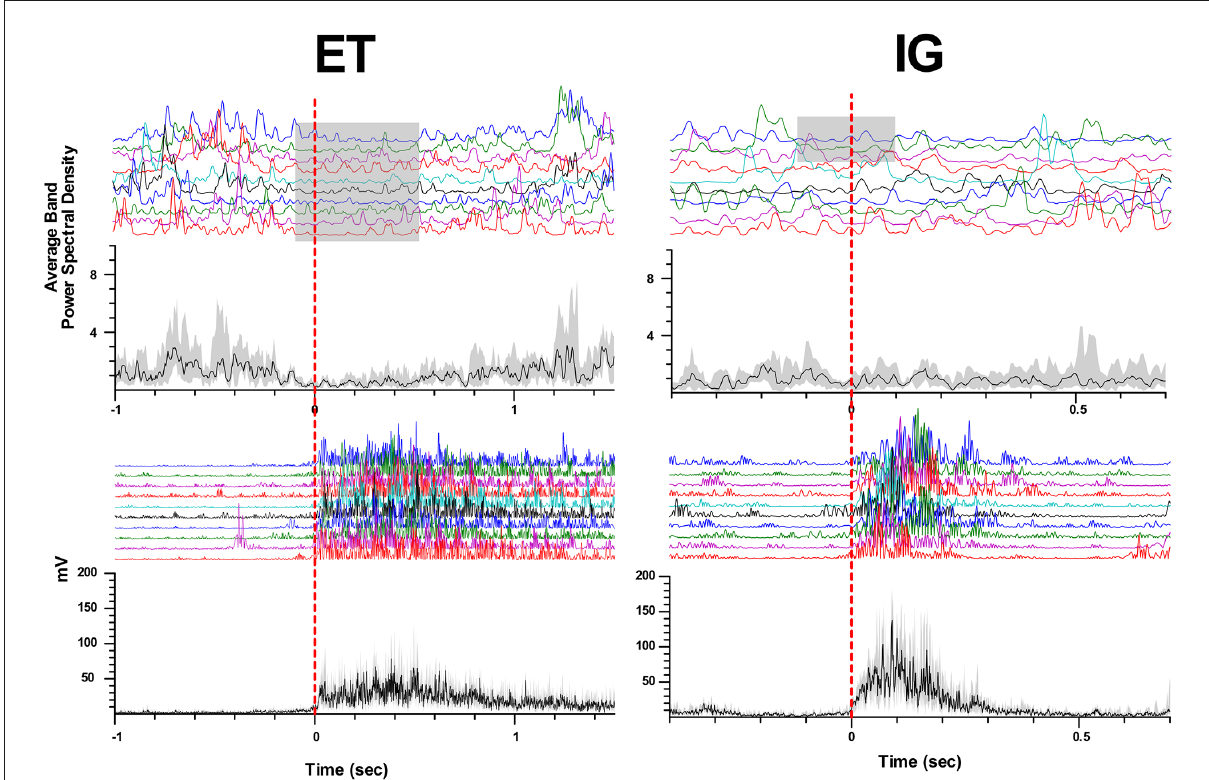
FIGURE3 Attenuation of beta desynchronization during repeated IG movements in PD. Examples of perievent raster and perievent histograms of beta energy power and rectified EMGs for ET and IG movements. X-axis: time, sec; y-axis: average beta energy power (a.u.) and rectified EMG amplitude (mV). The black line in perievent histograms shows the median value, and the gray area shows the interquartile